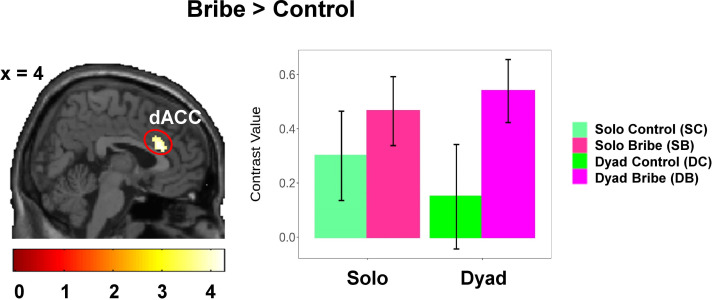
Enhanced dorsal part of anterior cingulate cortex (dACC) activity during bribery-related decision-making (Bribe vs. Control; GLM1c).The contrast values of the activated cluster were extracted for the visualization; error bars refer to SEM. Display threshold: voxel-level p (corrected) <0.001. L: left; R: right.